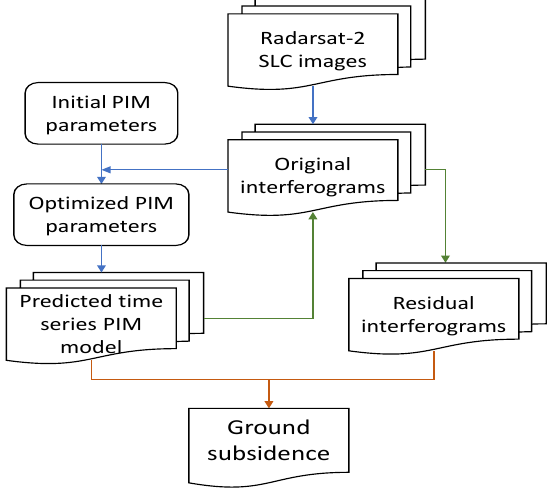
Figure 2. Overall processing